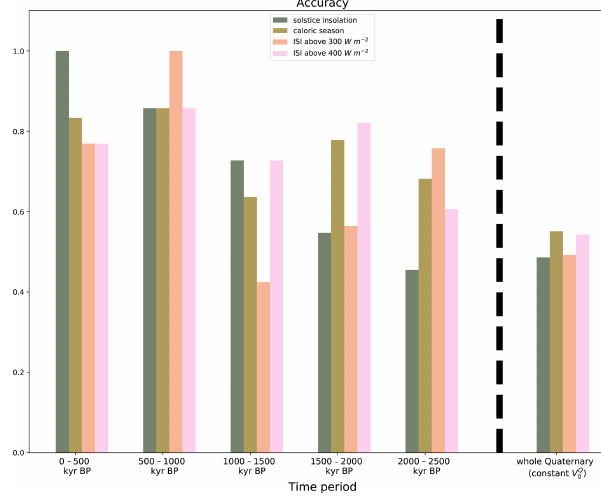
Figure 3. Accuracy over the five 500kyr periods for the four differ- ent summer insolation forcings at 65 ◦ N, and accuracy criteria over the Quaternary when the optimization procedure is done over the whole Quaternary (constant V Q 0 ). When several 0